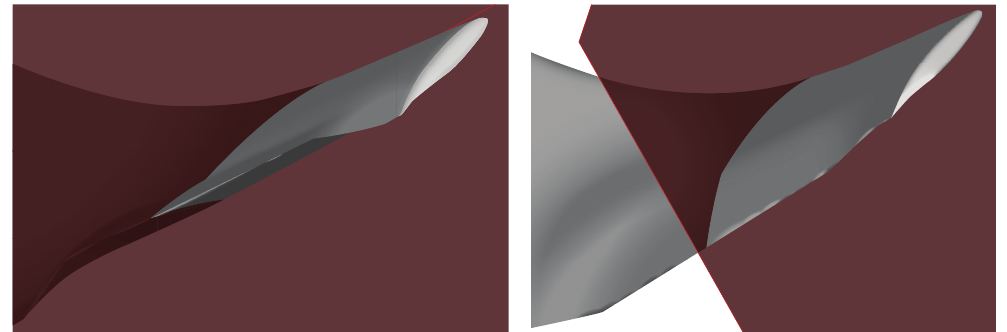
Figure 9: Parametric CAD model of a morphing